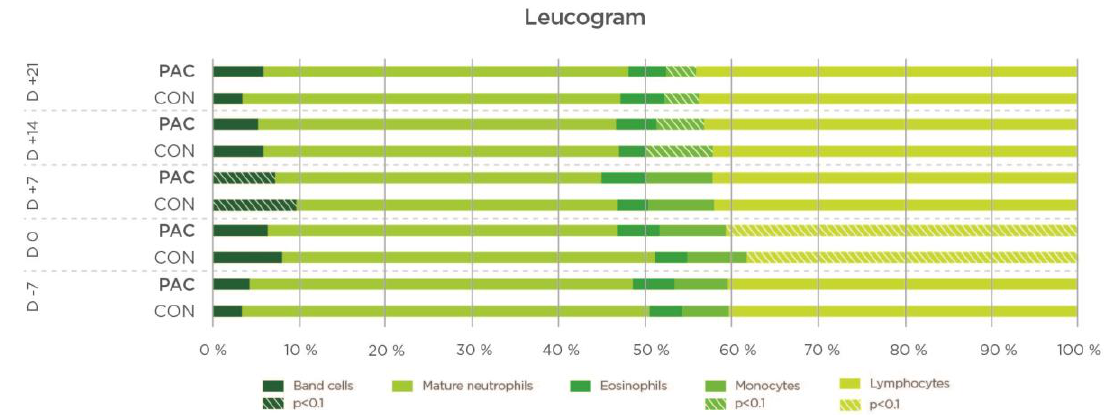
Figure 3. Effect of plant bioactive compounds on leucogram ( n = 23). Rectal Temperature. Fewer PAC cows showed rectal temperatures over 39 ◦ C during